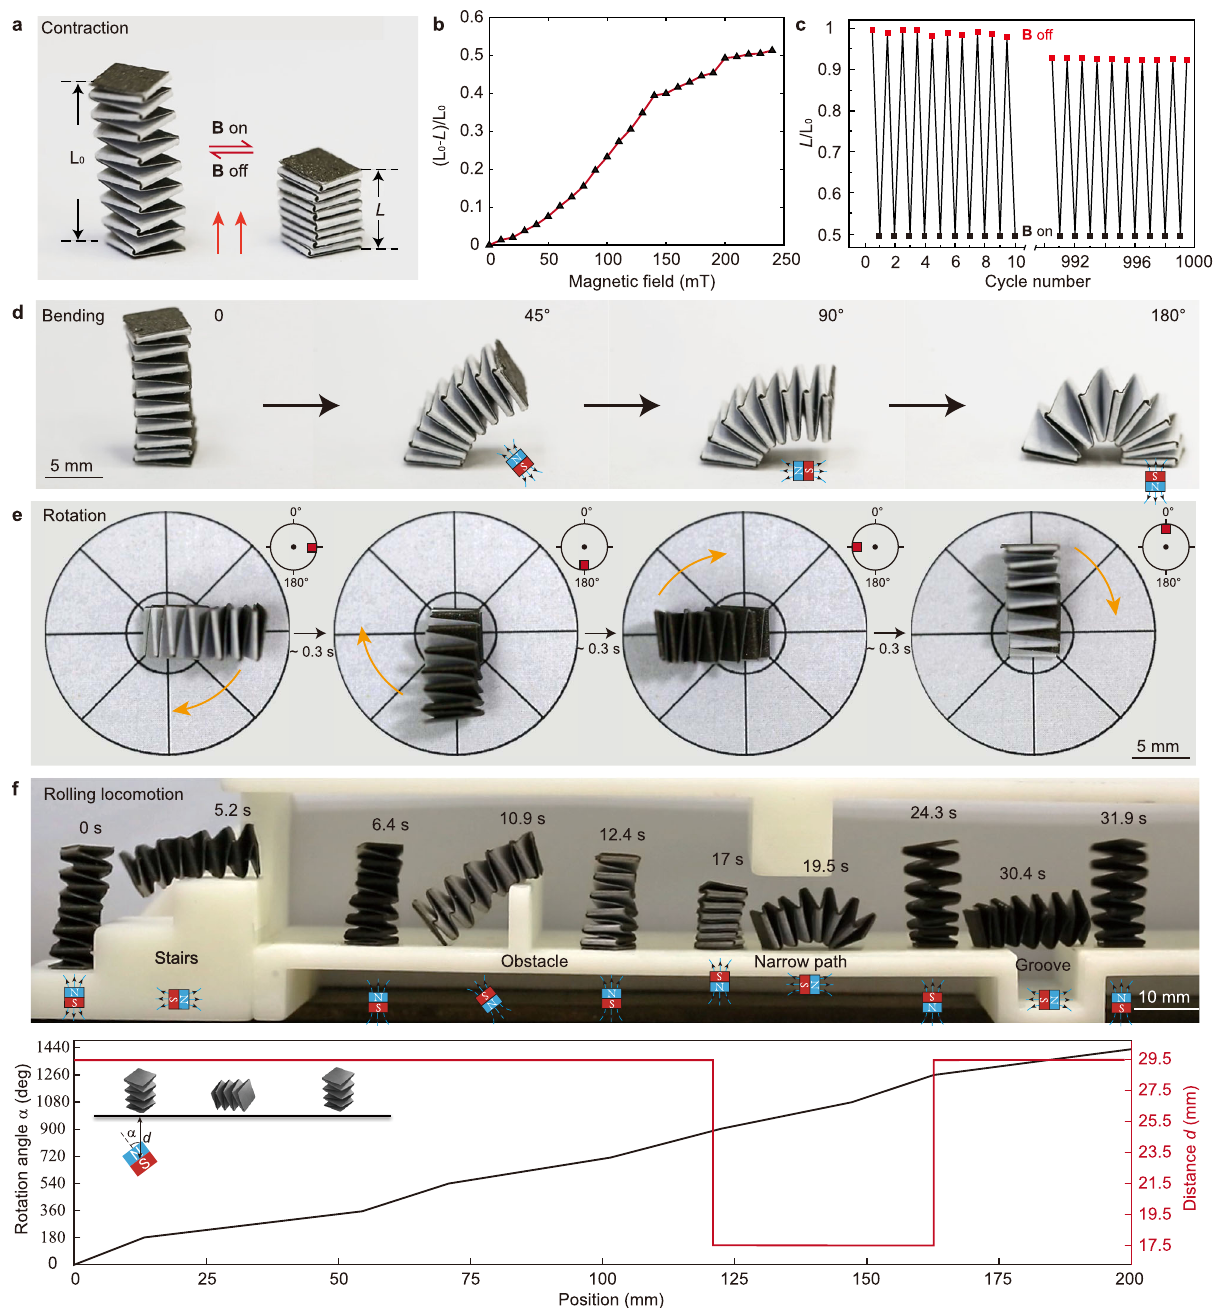
Fig. 5 Actuations of the magneto-origami spring actuator. a The spring actuator can contract when the magnet is placed in its axial direction. b The contraction ratio ð L 0 (cid:3) L Þ = L 0 of the spring actuator plotted as a function of magnetic fi eld strength up to 220 mT. c The spring actuator remains 93% of the original length L 0 after a 1000-cycle actuation (B ~220 mT). d Bending behaviors of the spring actuator. Panels show bending angles are 0°, 45°, 90°, 180°, respectively. e The 360° rotation behavior of a bent spring actuator by rotating the magnet surrounding the actuator. The yellow arrow represents the rotation direction of the rotating magnet. f Experimental demonstration of the rolling locomotion of the spring actuator by passing through several obstructions including stairs, obstacles, narrow path, and groove. The height of the stair, obstacle, and narrow path is 10, 10, and 12 mm, respectively. The width of the groove is 10 mm. Quantitative control schemes are provided in which rational angle α (left axis, blue curve) and distance d between the magnet and magneto-origami spring actuator is plotted as a function of the magnet